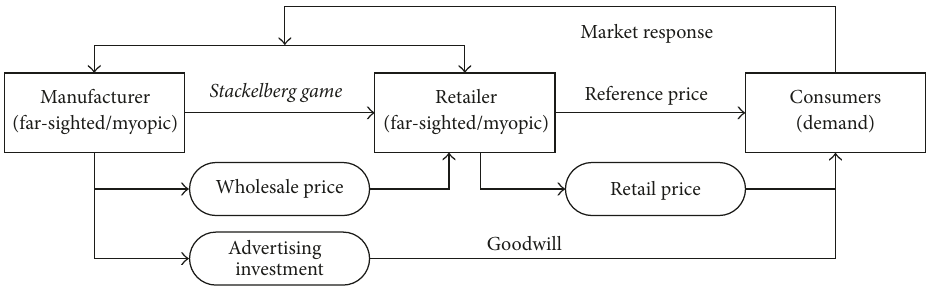
Figure 1: Mechanism of supply chain coordination through advertising with reference price